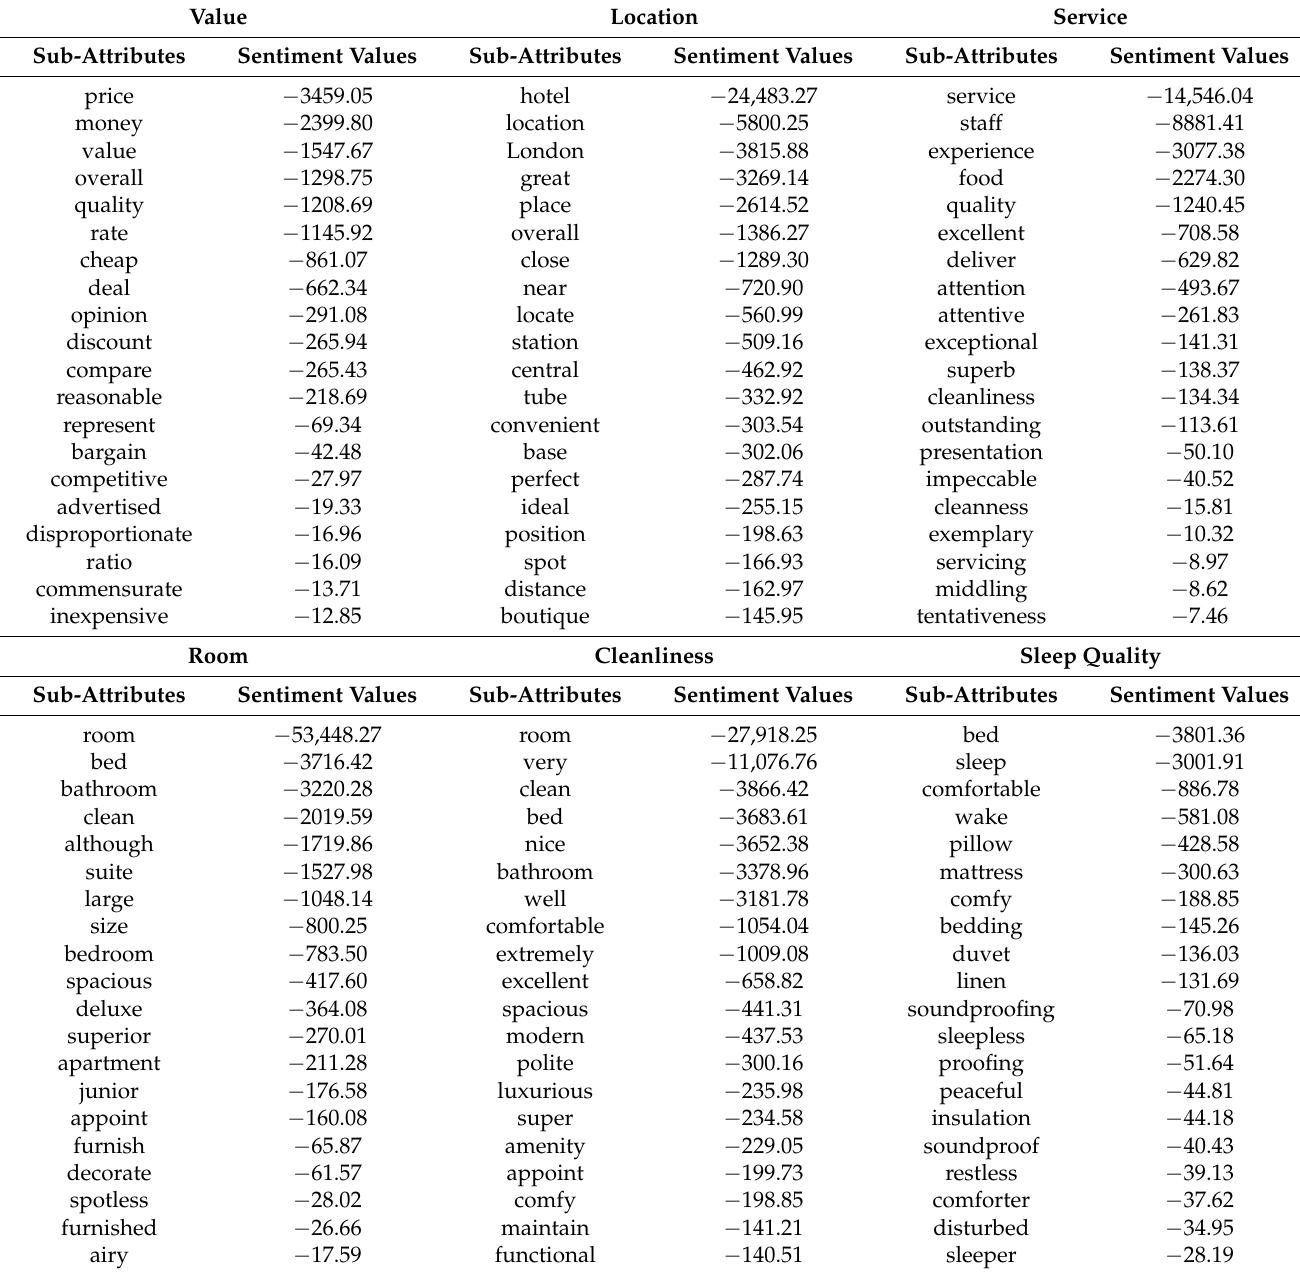
Table 8. Top 20 poorly performed sub-attributes with the strongest negative sentiment polarity with respect to six attributes in five-star